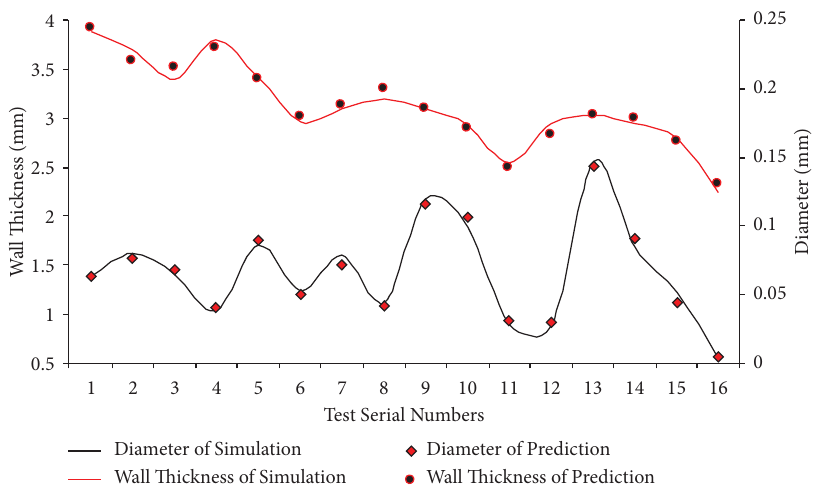
Figure 4: Diameter and wall thickness of simulation and